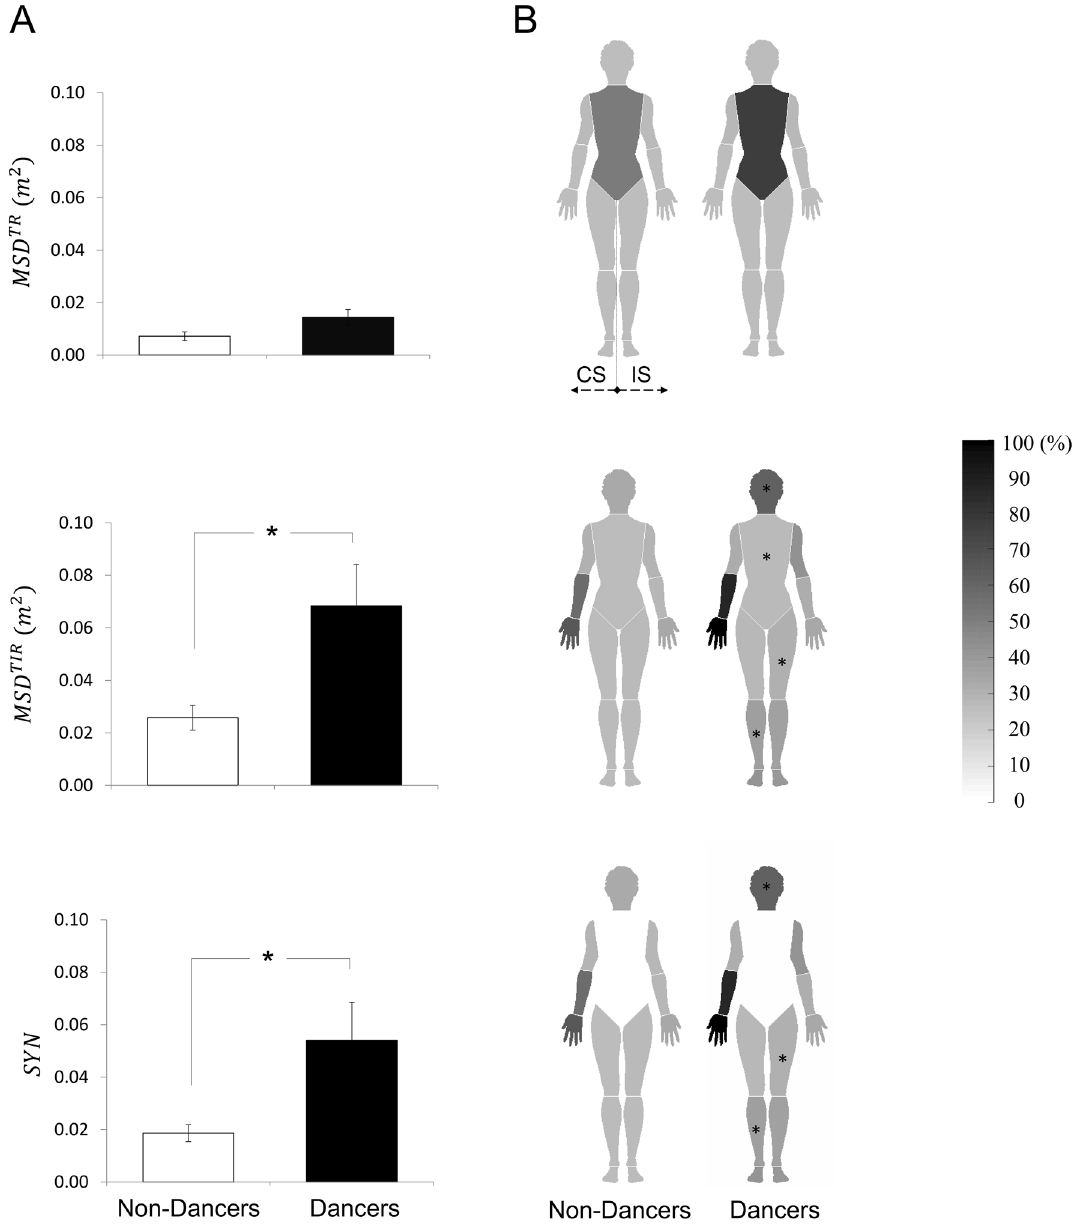
TR TIR ) ), task-irrelevant mean squared deviation ( MSD , TR TIR , MSD and SYN for dancers (white) TR TIR , MSD and SYN are shown as multi-segmental TIR TIR and SYN . Post hoc pairwise comparisons revealed that 1) MSD